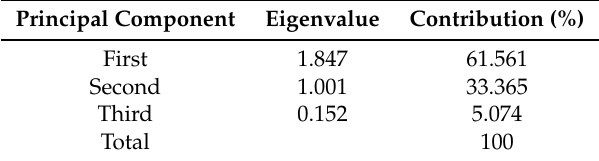
Table 7. Eigenvalues and contribution of